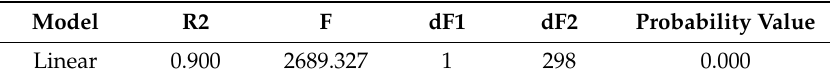
Table 4. The Summary for Ship Breadth Model.